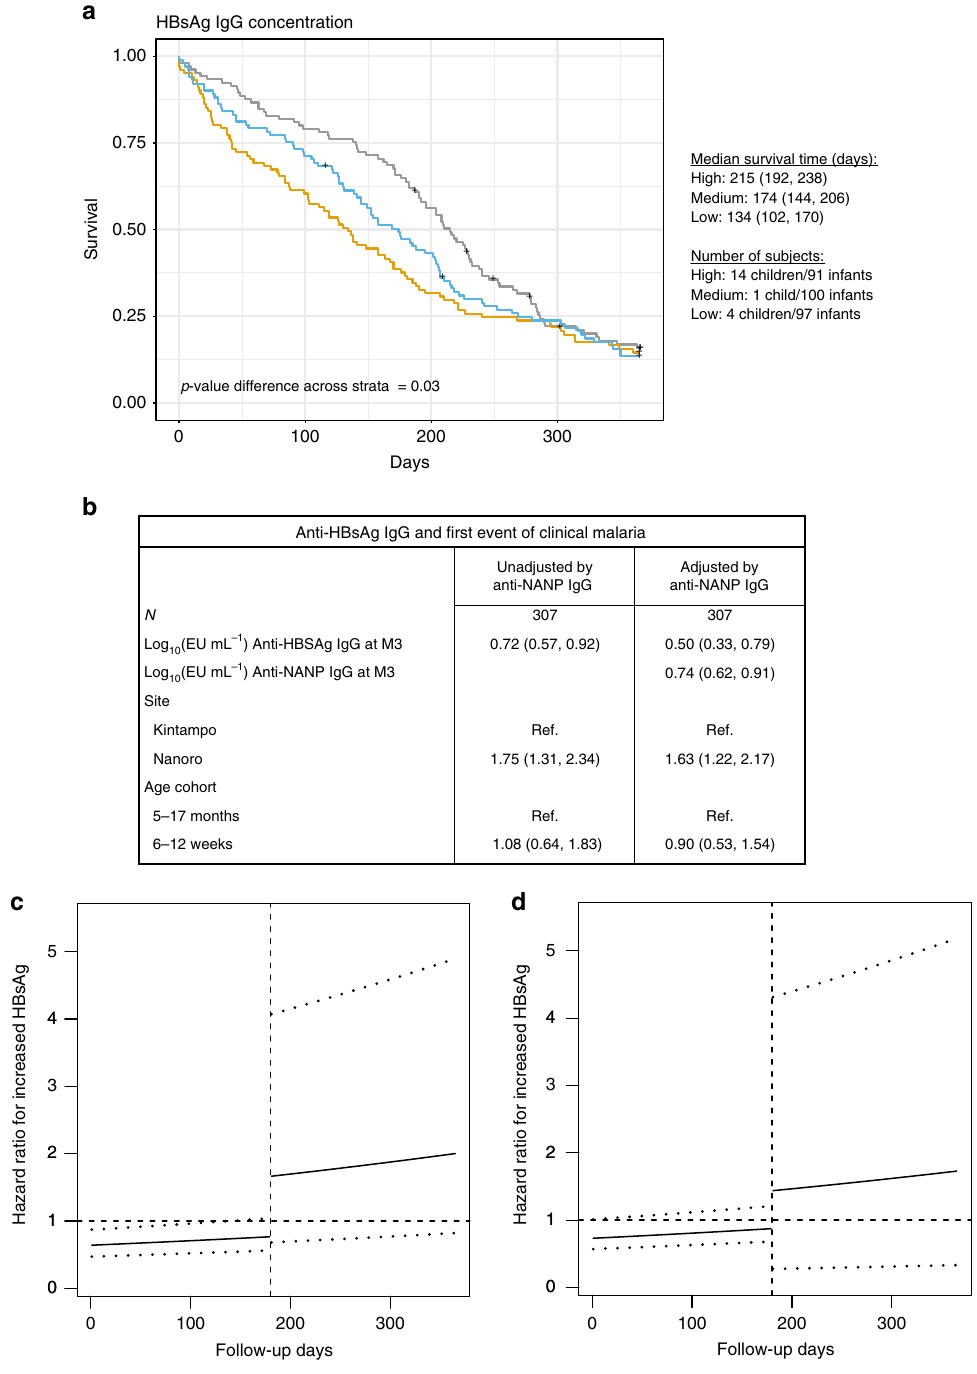
Fig. 6 Effect of HBsAg antibody concentration on protection against malaria episodes. Association between categorized anti-HBsAg IgG responses and time to the fi rst clinical malaria episode ( a ), and between continuous anti-HBsAg IgG responses and the hazard of fi rst ( b ) and recurrent ( c ) clinical malaria events within a 12-month follow-up period. a Kaplan – Meier curves of time to fi rst clinical malaria for subjects with anti-HBsAg IgG concentration in the upper (grey), intermediate (blue) and lower (yellow) tertiles. Median survival time (and 95% con fi dence interval [CI]) of subjects in each tertile and sample size strati fi ed by age group are shown, as well as the p -value of the log-rank test comparing survival time across tertile-based categories. b One unit increase in continuous anti-HBsAg IgG protects from clinical malaria in analysis unadjusted and adjusted for anti-NANP IgG concentration. c One unit increase in continuous anti-HBsAg IgG protects from clinical malaria until day 180 and is signi fi cantly protective of recurrent events of malaria (95% CI excludes 1) but 180 days after vaccination associations become not statistically signi fi cant. Comparable results are shown in d when repeating analysis of recurrent malaria events but adjusting for anti-NANP IgG concentration ( p -value of Schonfeld residual tests for analysis of recurrent events unadjusted for anti-NANP was 0.01 and adjusted for anti-NANP was 0.02, thus, rejecting a constant hazard ratio). All models were adjusted by study site and age